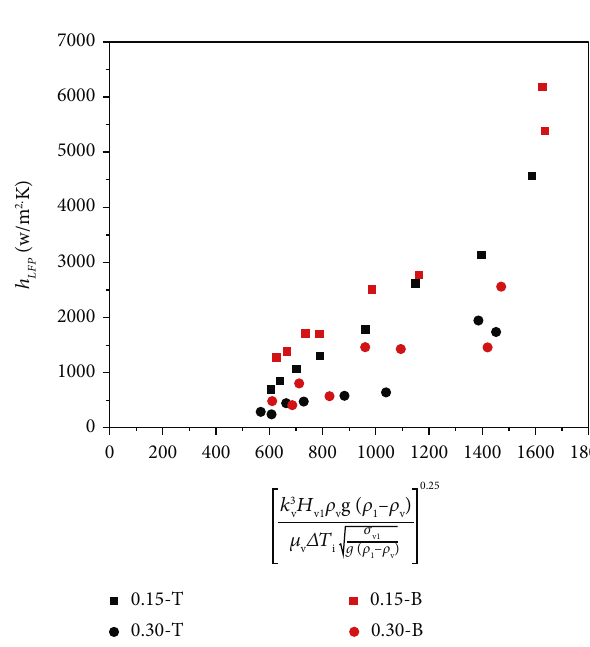
for class II. LFP